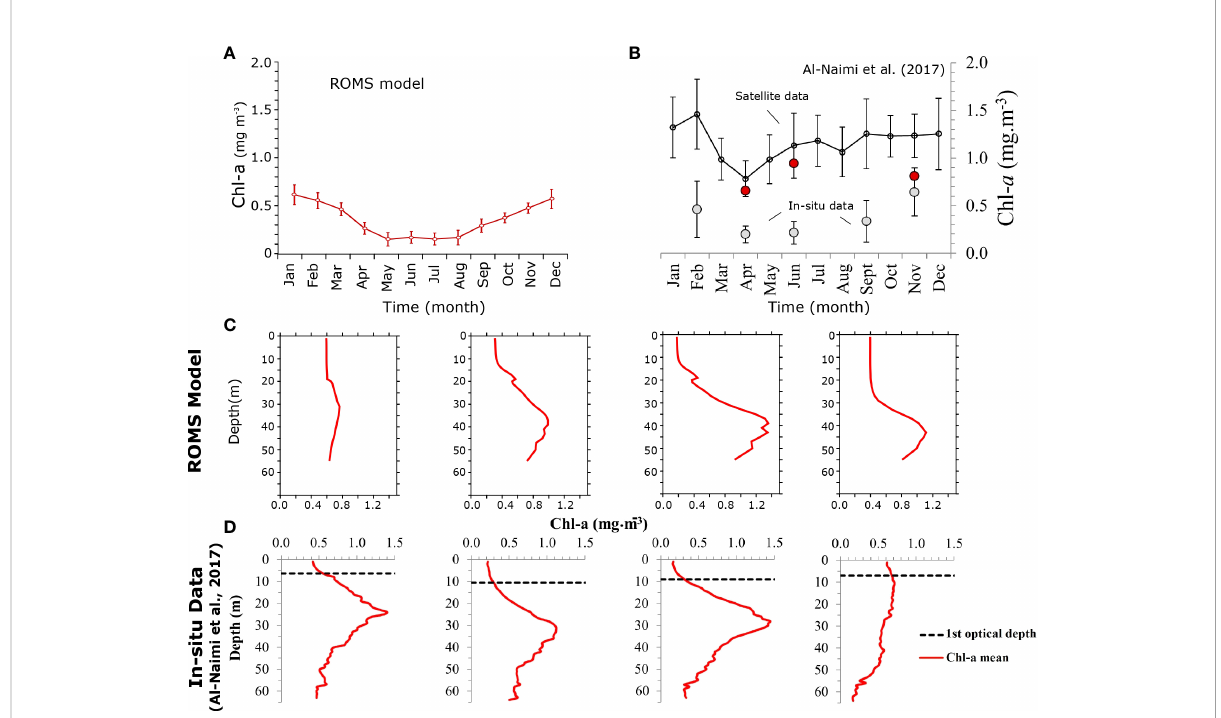
FIGURE 1 Evaluation of the model simulated chlorophyll-a concentrations (A, B) Seasonal surface Chl-a concentrations (in mg m -3 ) in the Qatar Exclusive Economic Zone (EEZ) (A) as simulated by ROMS and (B) from observations published by Al-Naimi et al. (2017). Gray circles show in-situ observations from six research cruises (2015-2016) while the black line indicates surface chl-a based on the OC-CCI satellite monthly climatology (1997-2013). (C, D) Vertical pro fi les of Chl-a in the Qatar EEZ in winter (DJF), spring (MAM), summer (JJA) and autumn (SON) seasons as simulated by (C) ROMS and (D) from in-situ measurements by Al-Naimi et al. (2017). Note that the seasonal in-situ chlorophyll pro fi les for winter, spring, summer and autumn are based on data collected in February 2016, April 2015/2016, June 2015, and September 2016/ November 2015,